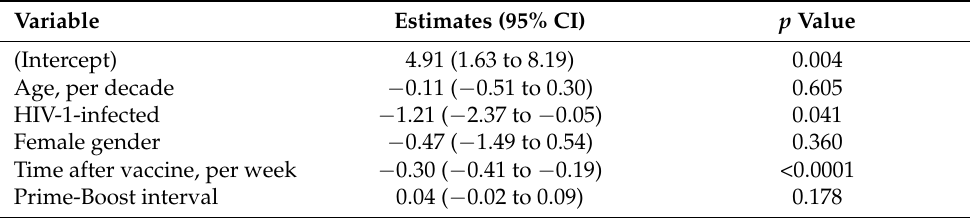
Table 4. Multivariate linear regression analysis of serum spike-specific IgA levels among SARS-CoV-2 vaccinated